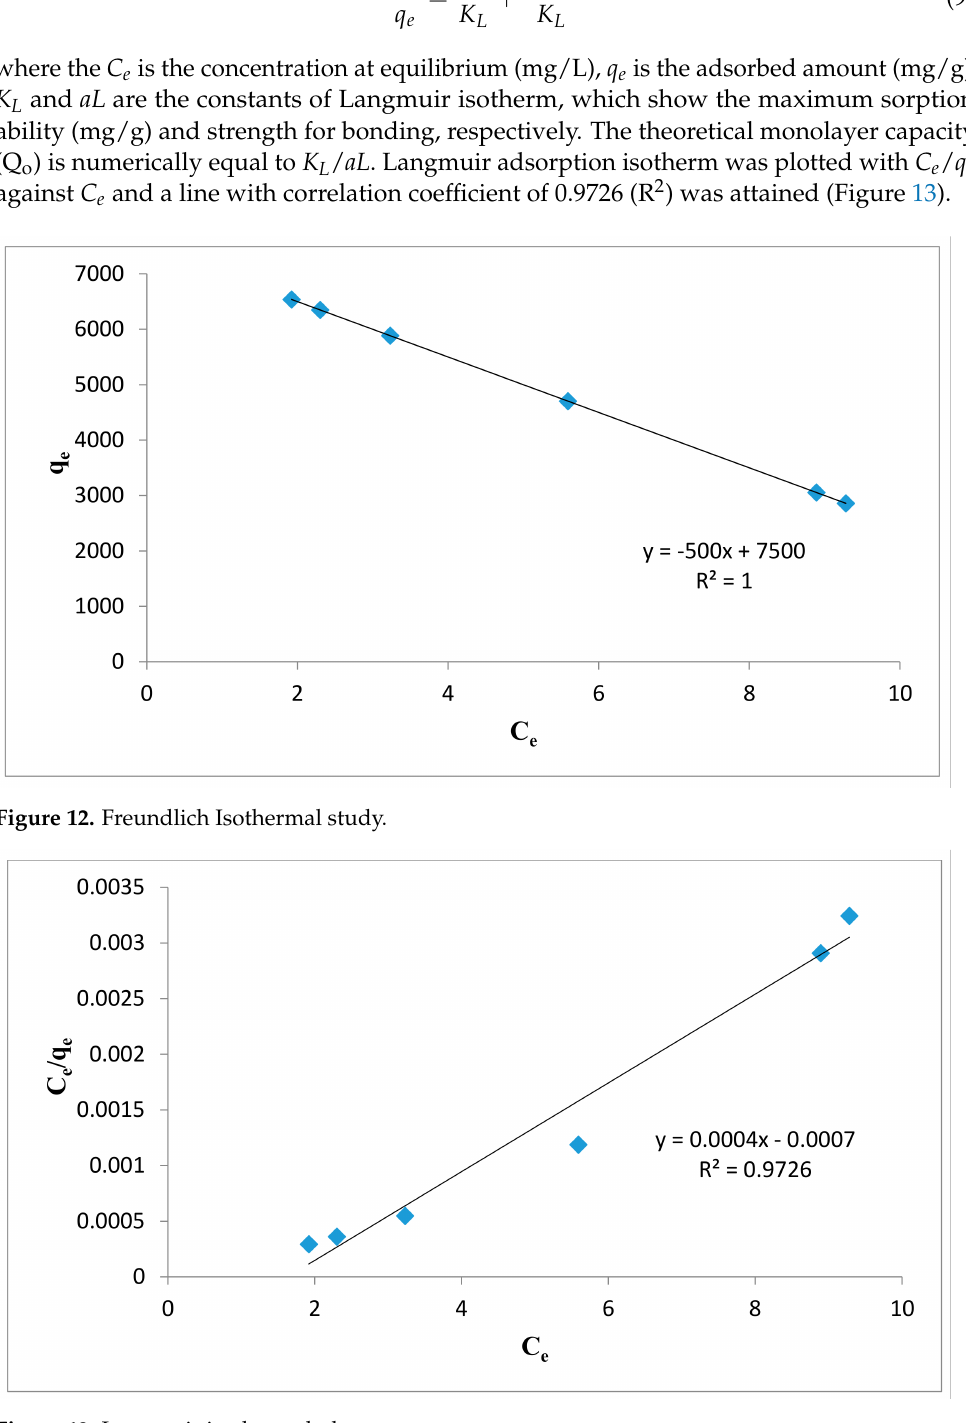
Figure 13. Langmuir isothermal